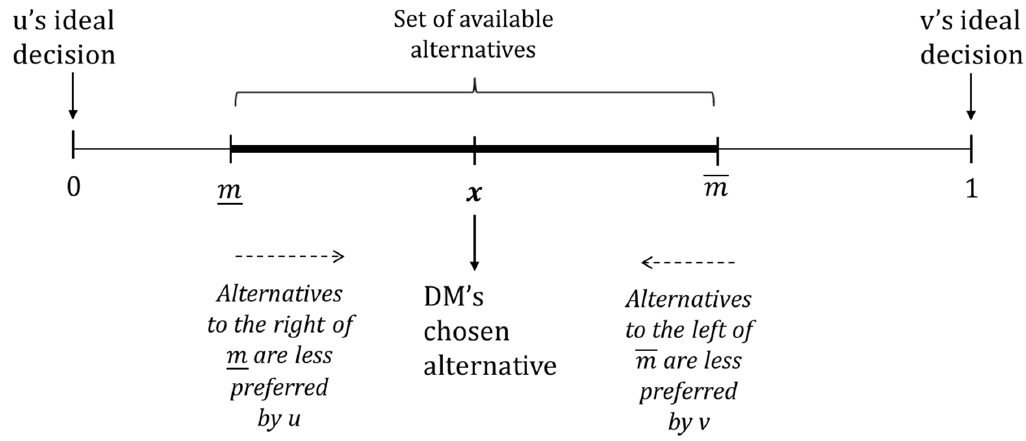
Figure 1. The Hotelling line decision dilemma interval with a set of available alternatives [ m , m ]